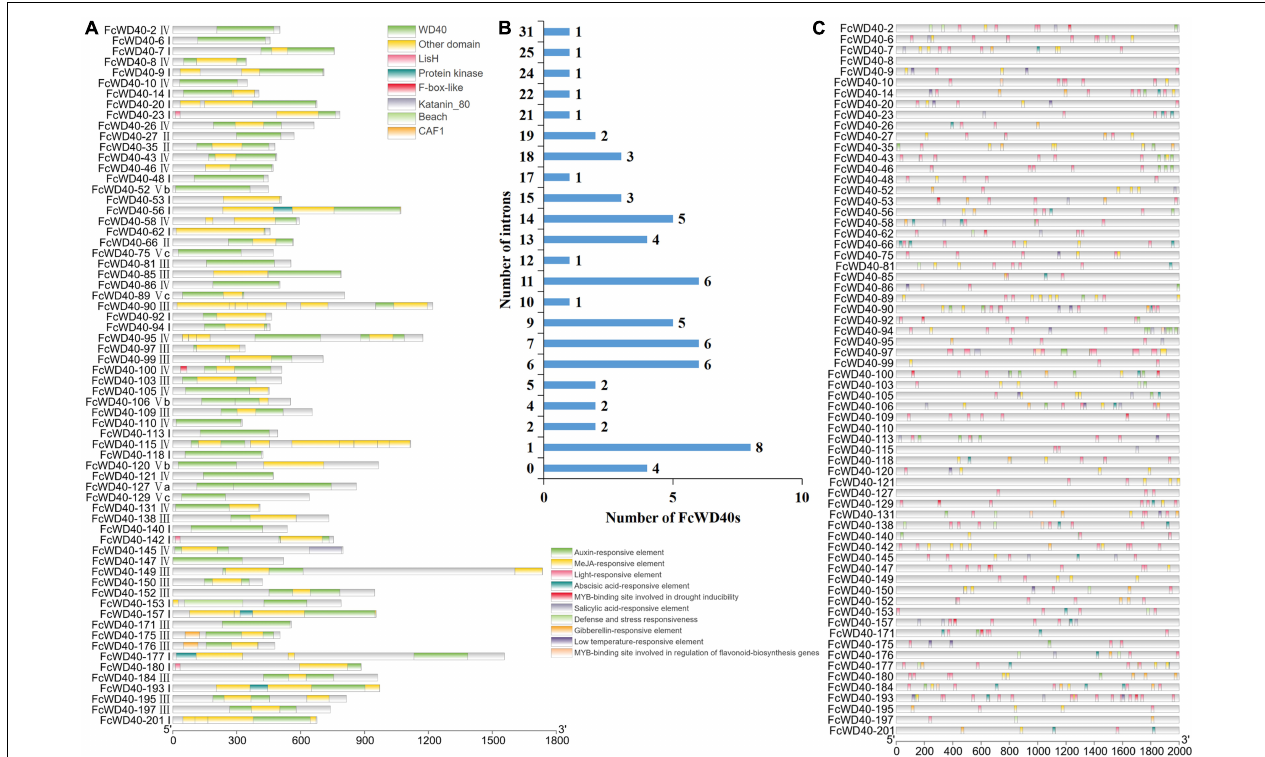
FIGURE 2 | Analysis of domain structure and promoter of FcWD40s. (A) Distribution of primary domains of 66 FcWD40 proteins with nuclear localization and genes expressed in fig fruit. (B) Introns number of 66 FcWD40s. (C) Promoter analysis of FcWD40 s by Plant CARE, based on 2000-bp sequence upstream of the genes.